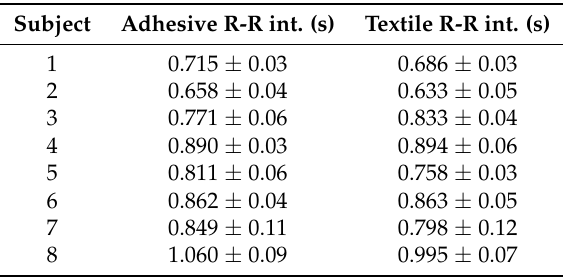
Table 3. R-R interval for textile and adhesive electrodes for each subject.